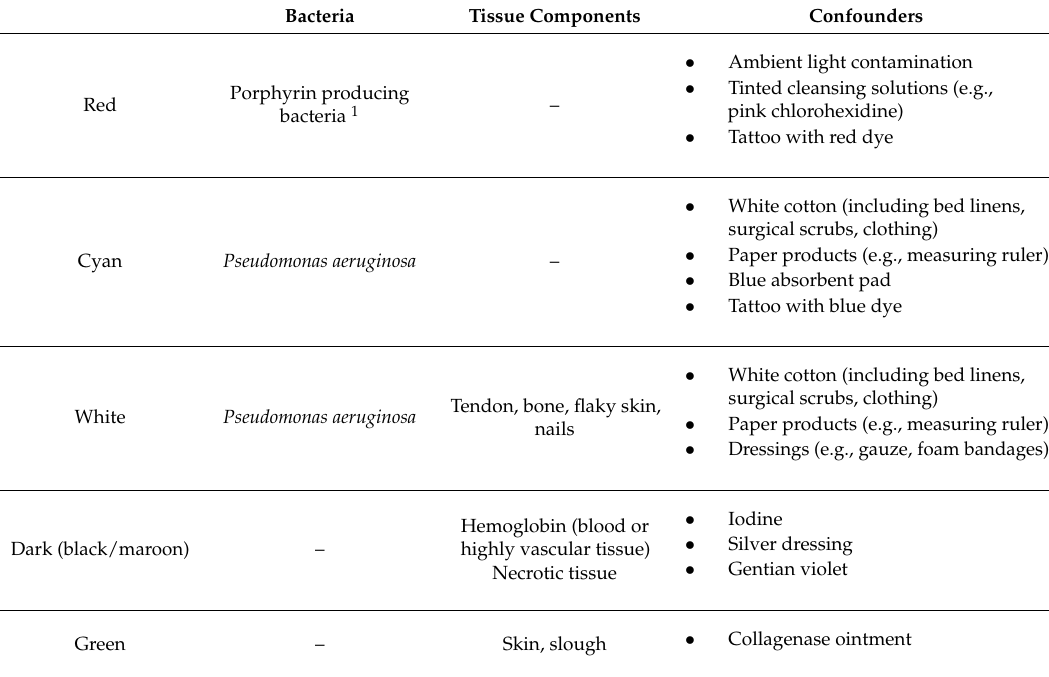
Table 1. Potential sources of fluorescence on MolecuLight i:X